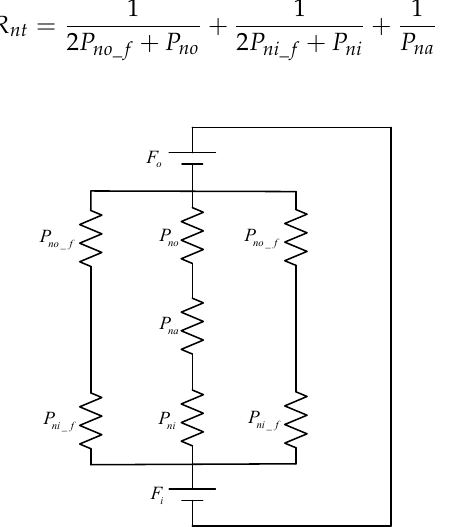
Figure 14. Equivalent magnetic circuit of completely unaligned position between stator and rotor in Figure 8.